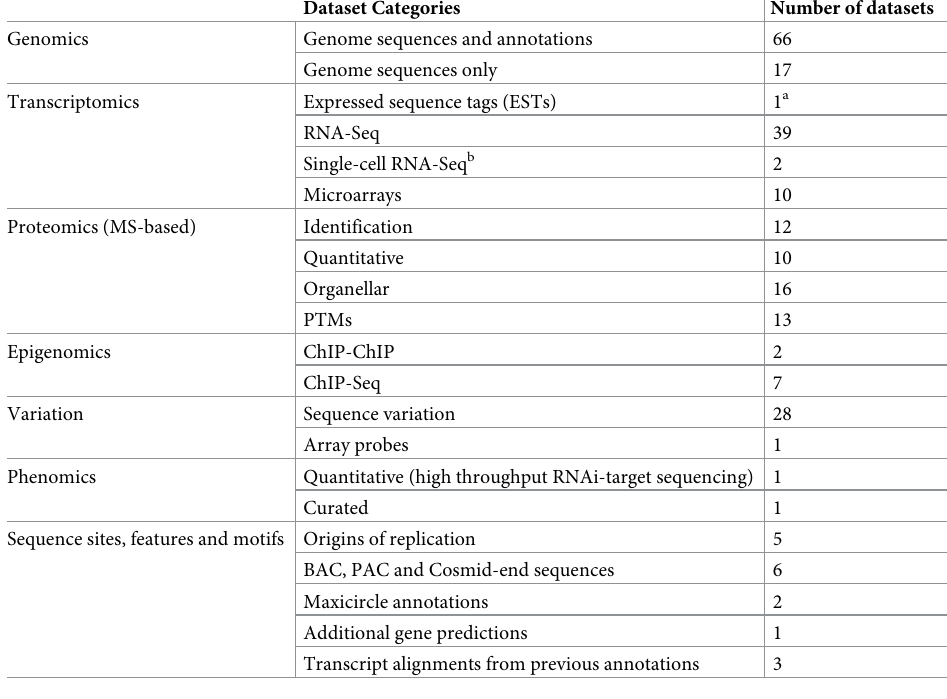
Table 1. Summary of integrated